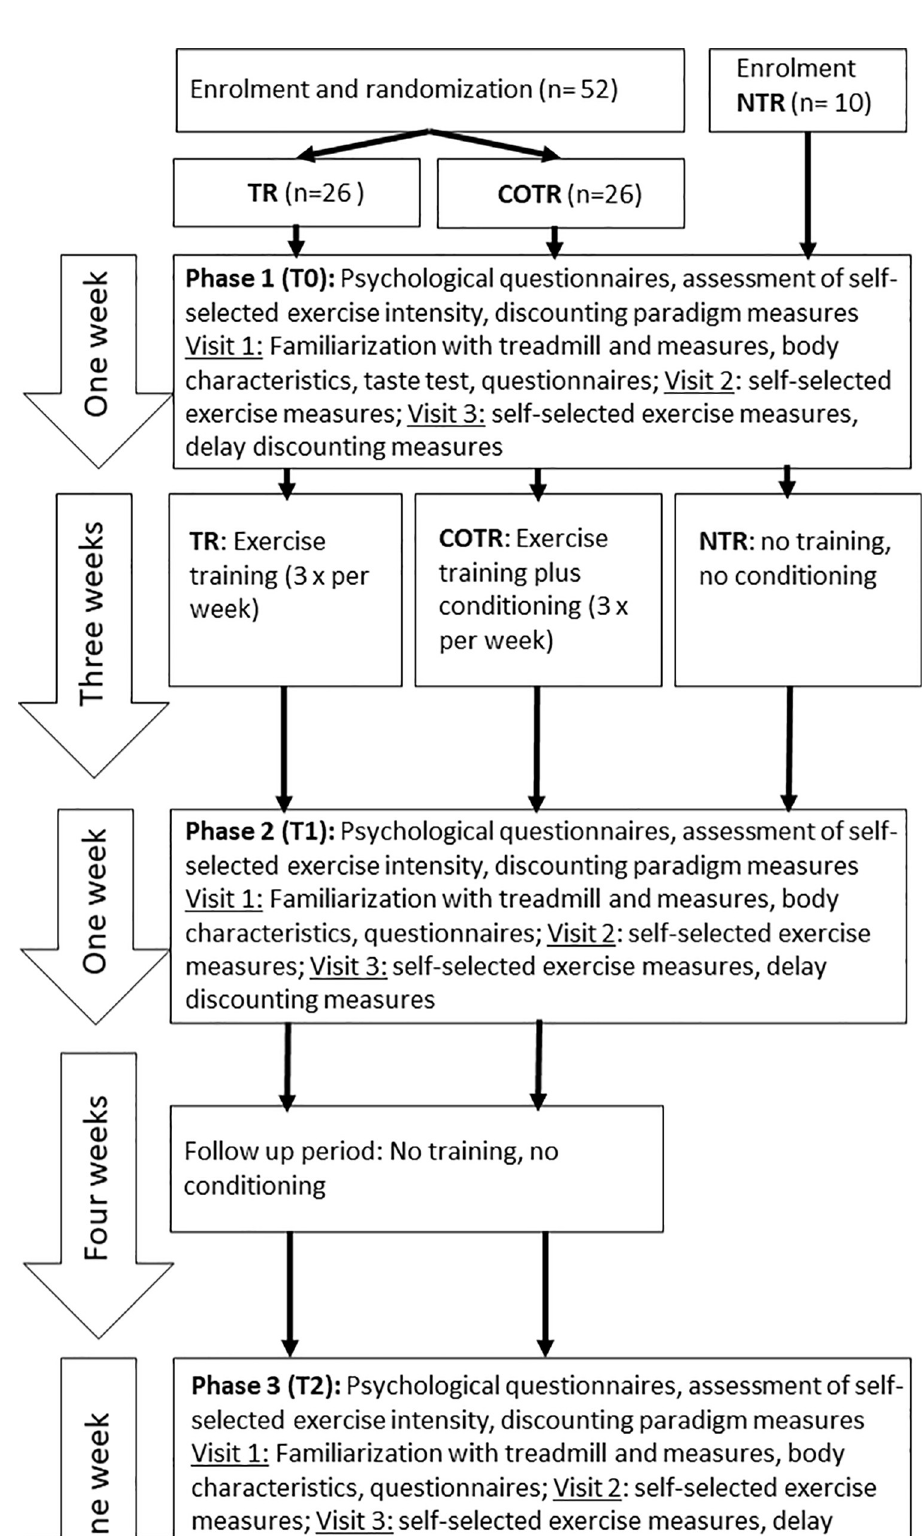
Fig 1. Flow diagram of the intervention through the phases baseline (T0), post-training (T1), and follow-up (T2). https://doi.org/10.1371/journal.pone.0257953.g001 PLOS ONE | https://doi.org/10.1371/journal.pone.0257953 October 6,